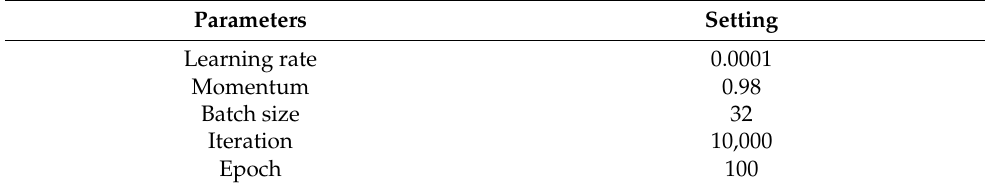
Table 1. The parameters setting in the training stage of the proposed